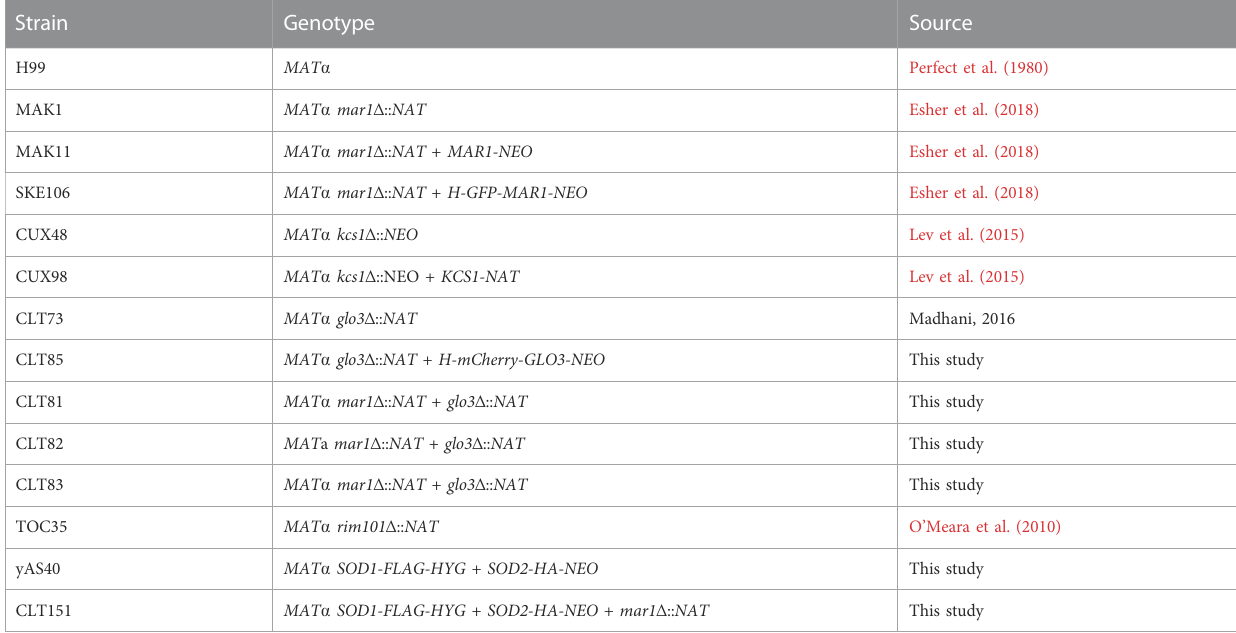
TABLE 1 Strains used in this study. All strains used in this study are included, along with the genotype and source of each strain. Strain